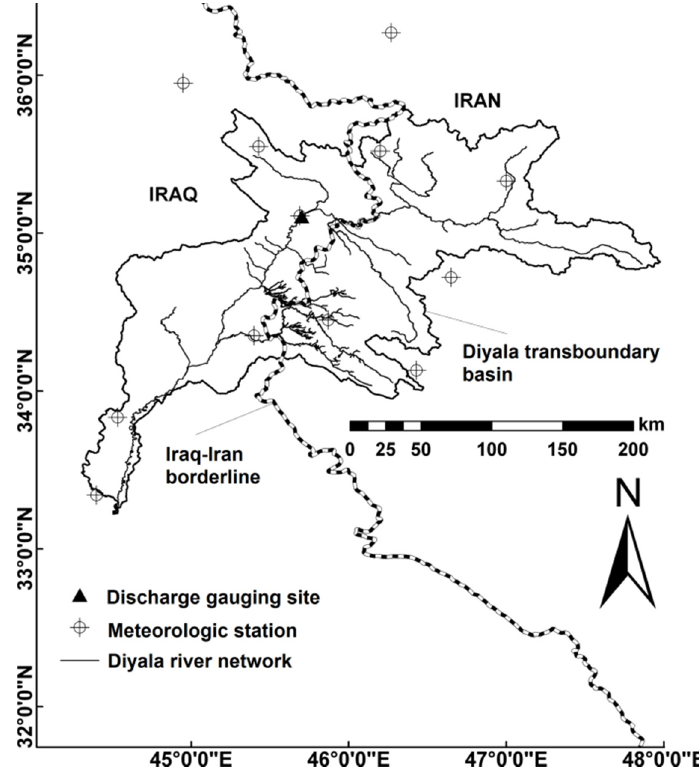
Figure 1. Diyala watershed (case study example) and the locations of the hydro-meteorological